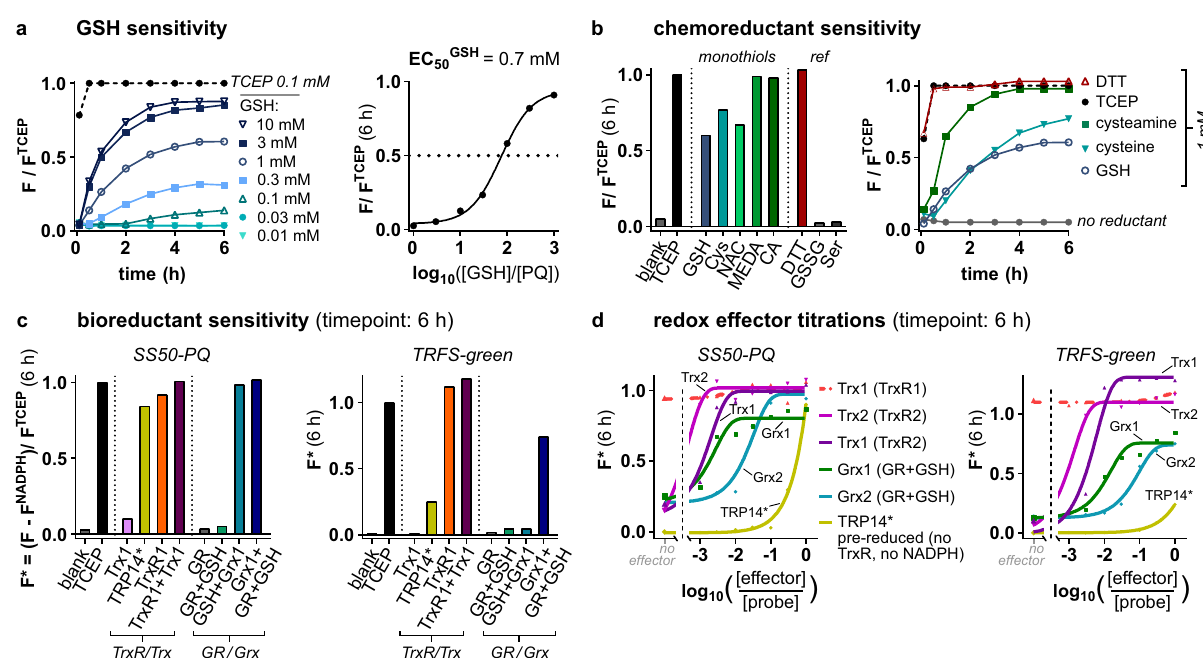
Fig. 3 1,2-dithiolane probes are activated by a range of chemical and biological reductants. a GSH challenge. Fluorescence timecourses of SS50-PQ exposed to GSH, and the corresponding dose-response plot ( t = 6 h at 37 °C). b Chemical reductant assays. Normalised signal from SS50-PQ challenged with monothiols (GSH, cysteamine (CA), cysteine (Cys), and mercaptoethyl-dimethylamine (MEDA) each at 1 mM), dithiol (1 mM dithiothreitol (DTT)), non-reductants (GSH disul fi de (GSSG) and serine (Ser) each at 1 mM), or tris(2-carboxyethyl)phosphine (TCEP) (100 µ M); showing all endpoint results (6 h at 37 °C) and selected kinetics. c Redox enzyme assays. Normalised signal from SS50-PQ and TRFS-green challenged with TrxR/Trx or GR/GSH/Grx network proteins (20 nM TrxR1/GR, 10 µ M Trx1/Grx1/TRP14*, 100 µ M GSH as indicated; 100 µ M NADPH in all TrxR/GR assays). d Dose – response plots for redox effector proteins (20 nM TrxR1/TrxR2/GR, 0.03 – 10 µ M Trx1/Grx1/TRP14*, 100 µ M GSH as indicated; 100 µ M NADPH in all TrxR/GR assays). ( a – d : data are for single representative examples from either 2 ( b ) or 3 ( a , c , d ) independent experiments; probes at 10 µ M in aqueous TE-buffer; notation TRP14* indicates pre-reduced TRP14 (see “ Methods ”